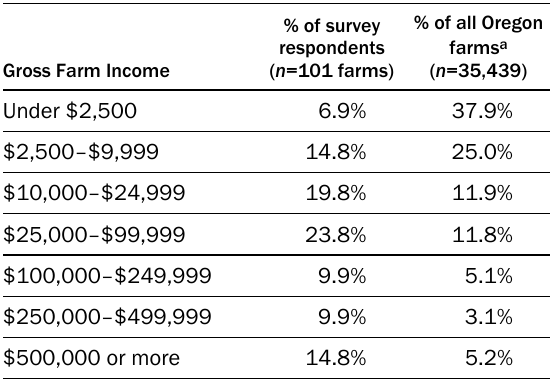
Table 1. Comparison of Surveyed Farms vs. Figure 1. Proportion of Respondents in Each